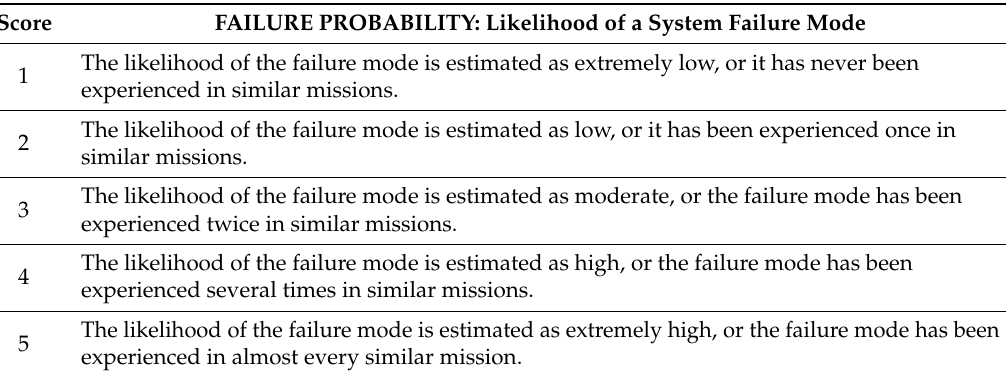
Table 2. Failure probability coefficients.